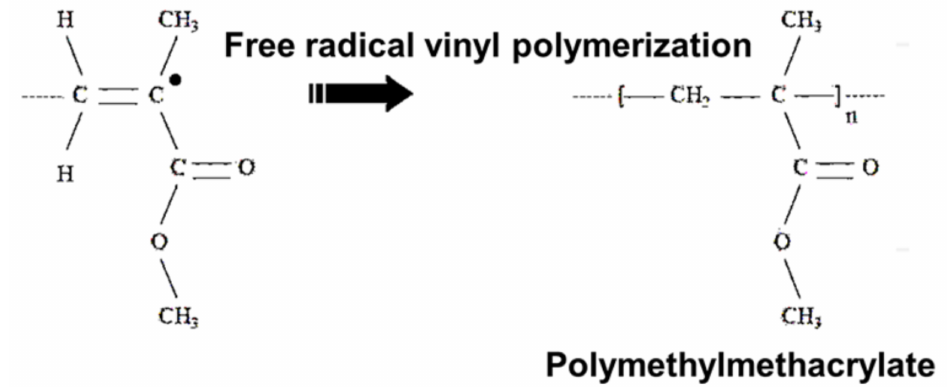
Figure 1. Formation of a polymer chain of PMMA cement. Reused from an Open Access article